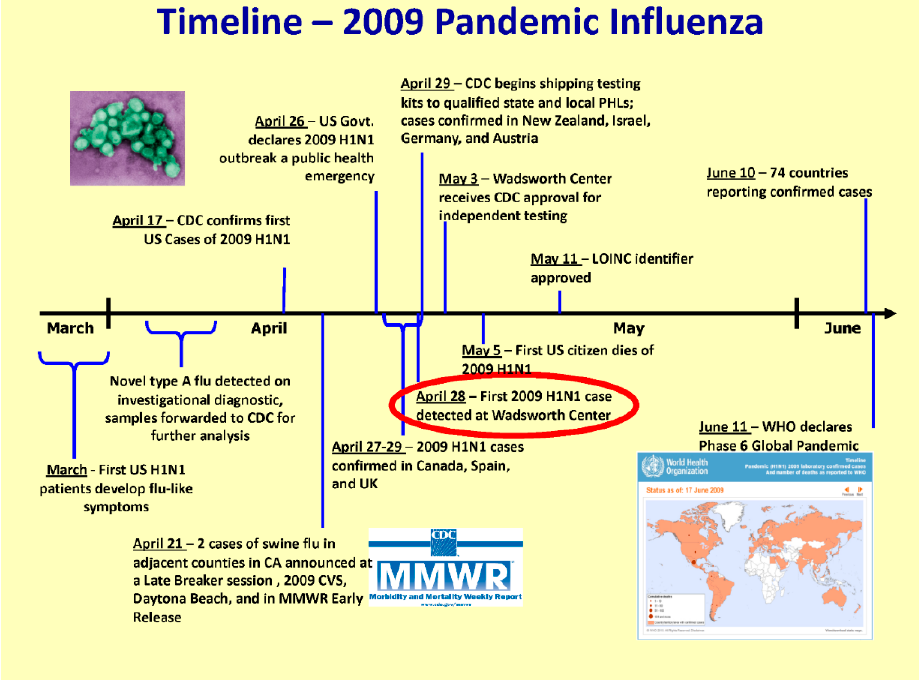
Figure 2. The timeline of the 2009 influenza pandemic and the emergency response by the international World Health Organization, the U.S. Centers for Disease Control and Prevention (CDC) and the NYS Wadsworth Center.